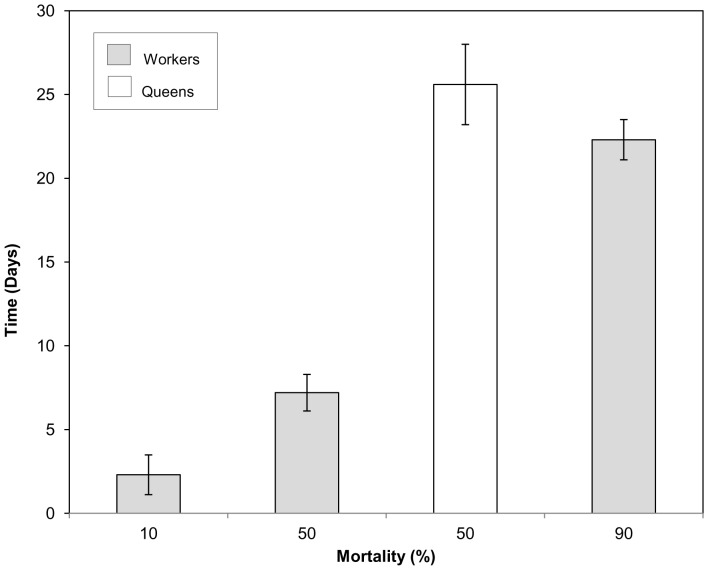
Lower Lethal Times at 0°C of worker and queen bumblebees (Bombus terrestris audax).The LLTime10,50 and LLTime90 at 0°C (±SE) of worker bumblebees as determined by Probit analysis, n = 30 per duration.